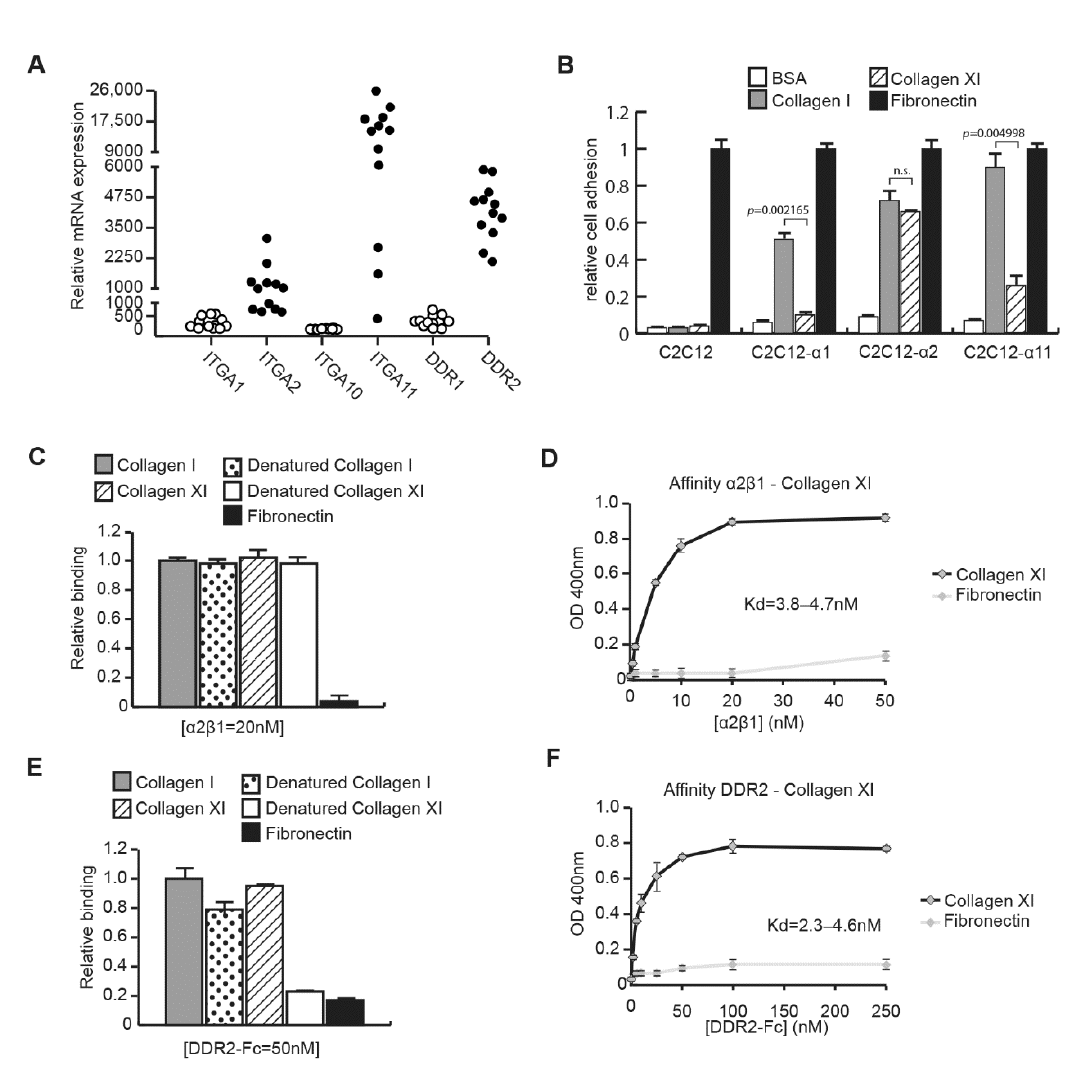
Figure 2. Integrin α 2 β 1 and DDR2 bind to collagen type XI. ( A ) Expression of collagen receptors on CAF. Expression of integrin α 1 (ITGA1), integrin α 2 (ITGA2), integrin α 10 (ITGA10), integrin α 11